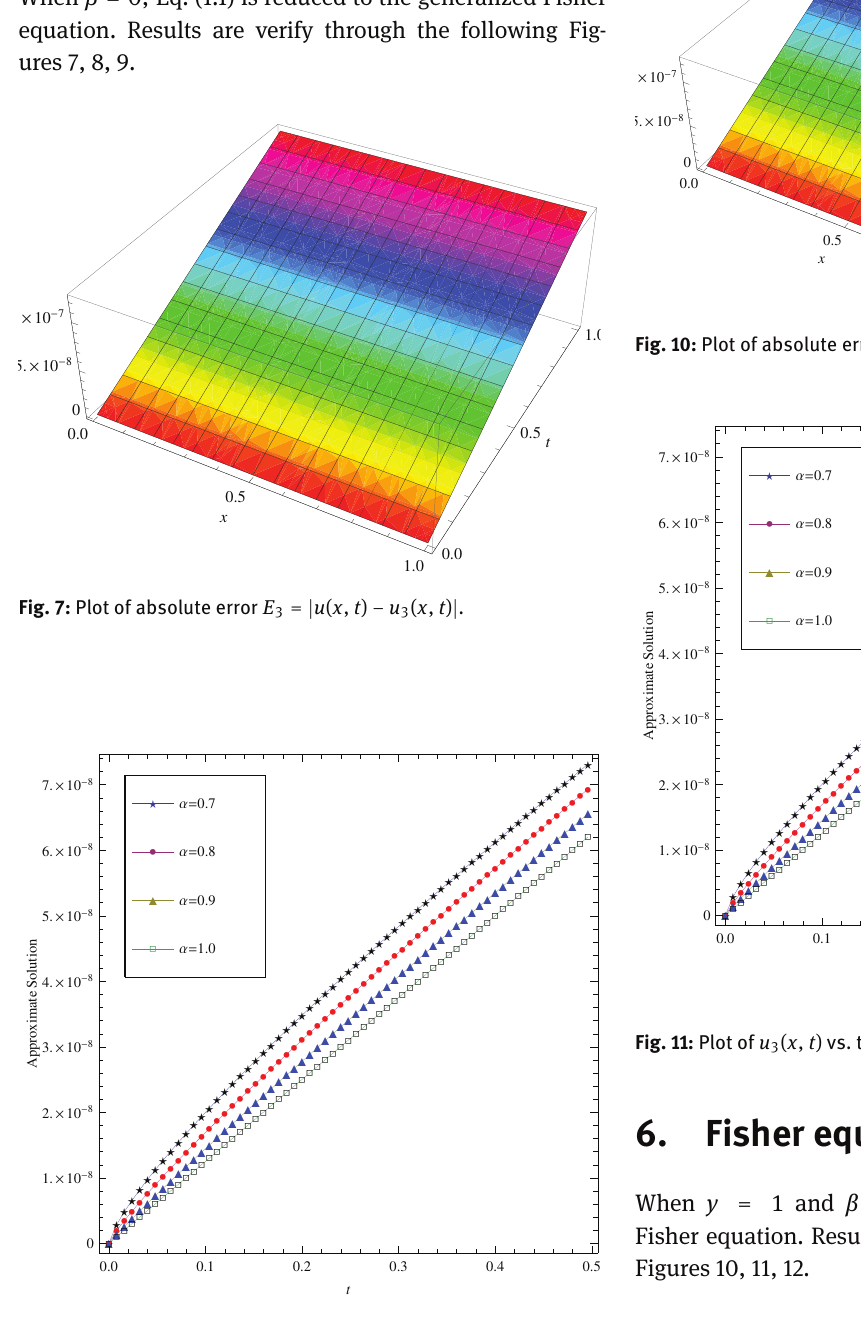
Fig. 8: Plot of u 3 ( x , t ) vs. time t at x = 1 and different value of α .